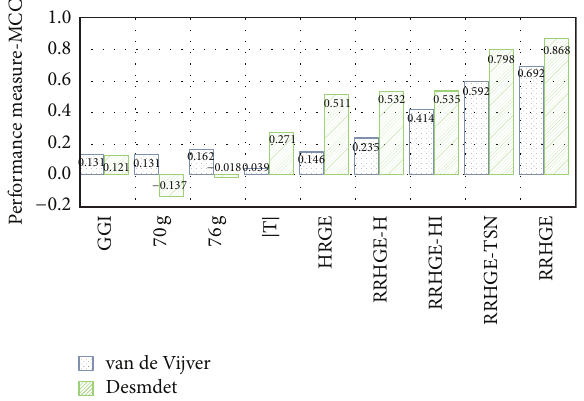
Figure 3: Bar charts represent the MCCs of various classification algorithms on Desmedt and van de Vijver datasets,